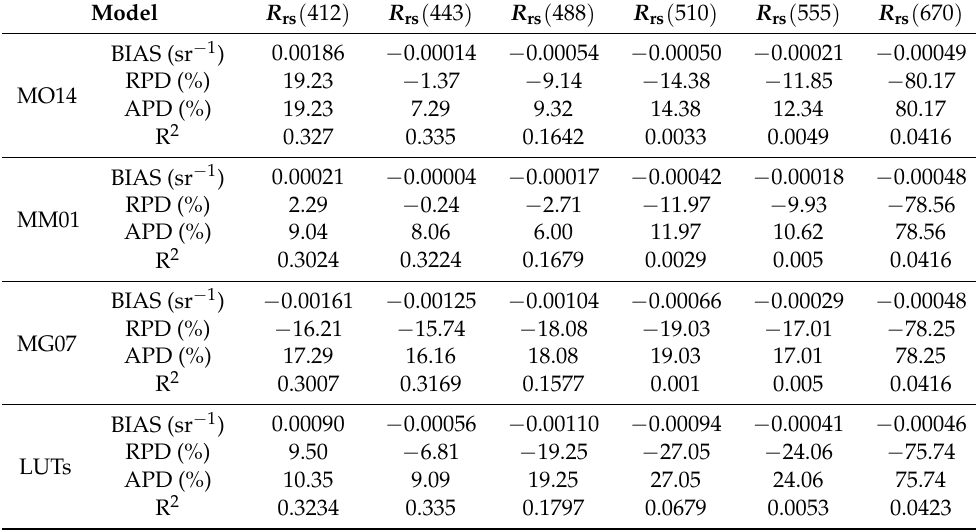
Figure 9. Performance of MM01, MG07, MO14 and LUTs models using the dataset from the South China Sea (( a ) MO14 , ( b ) MM01, ( c ) MG07, ( d ) LUTs). Table 2. Statistical parameters between MM01, MG07, MO14 and LUTs models using the South China Sea